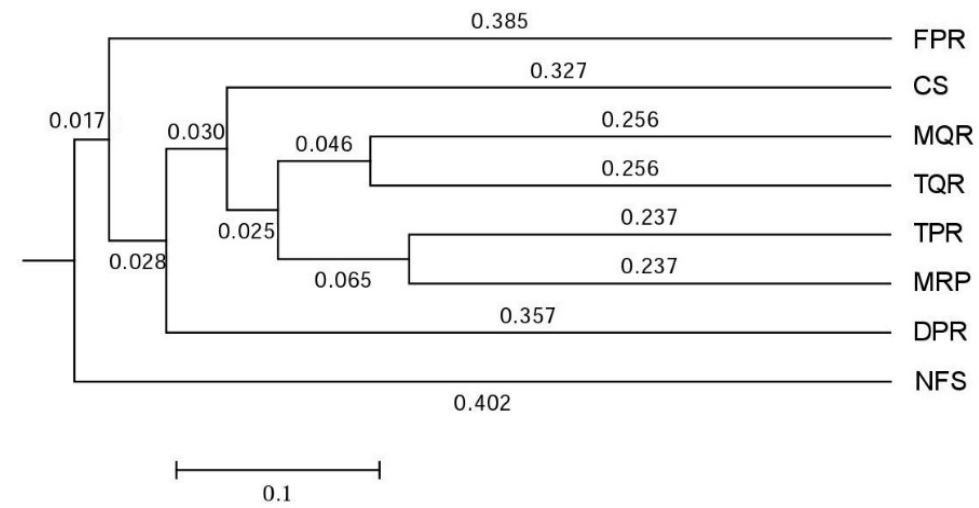
Figure 4. Hierarchical clustering of soil fungal communities according to the Bray-Curtis similarity algorithm and unweighted pair group with arithmetic mean. CS, control soil; MPR, middle portion of Pinus tabuliformis roots; TPR, tips of P. tabuliformis roots; MQR, middle portion of Quercus variabilis roots; tips of Q. variabilis roots; FPR, post-fire planted forest of P. tabuliformis ; DPR, dead P. tabuliformis roots; NFS, natural P. tabuliformis forest.